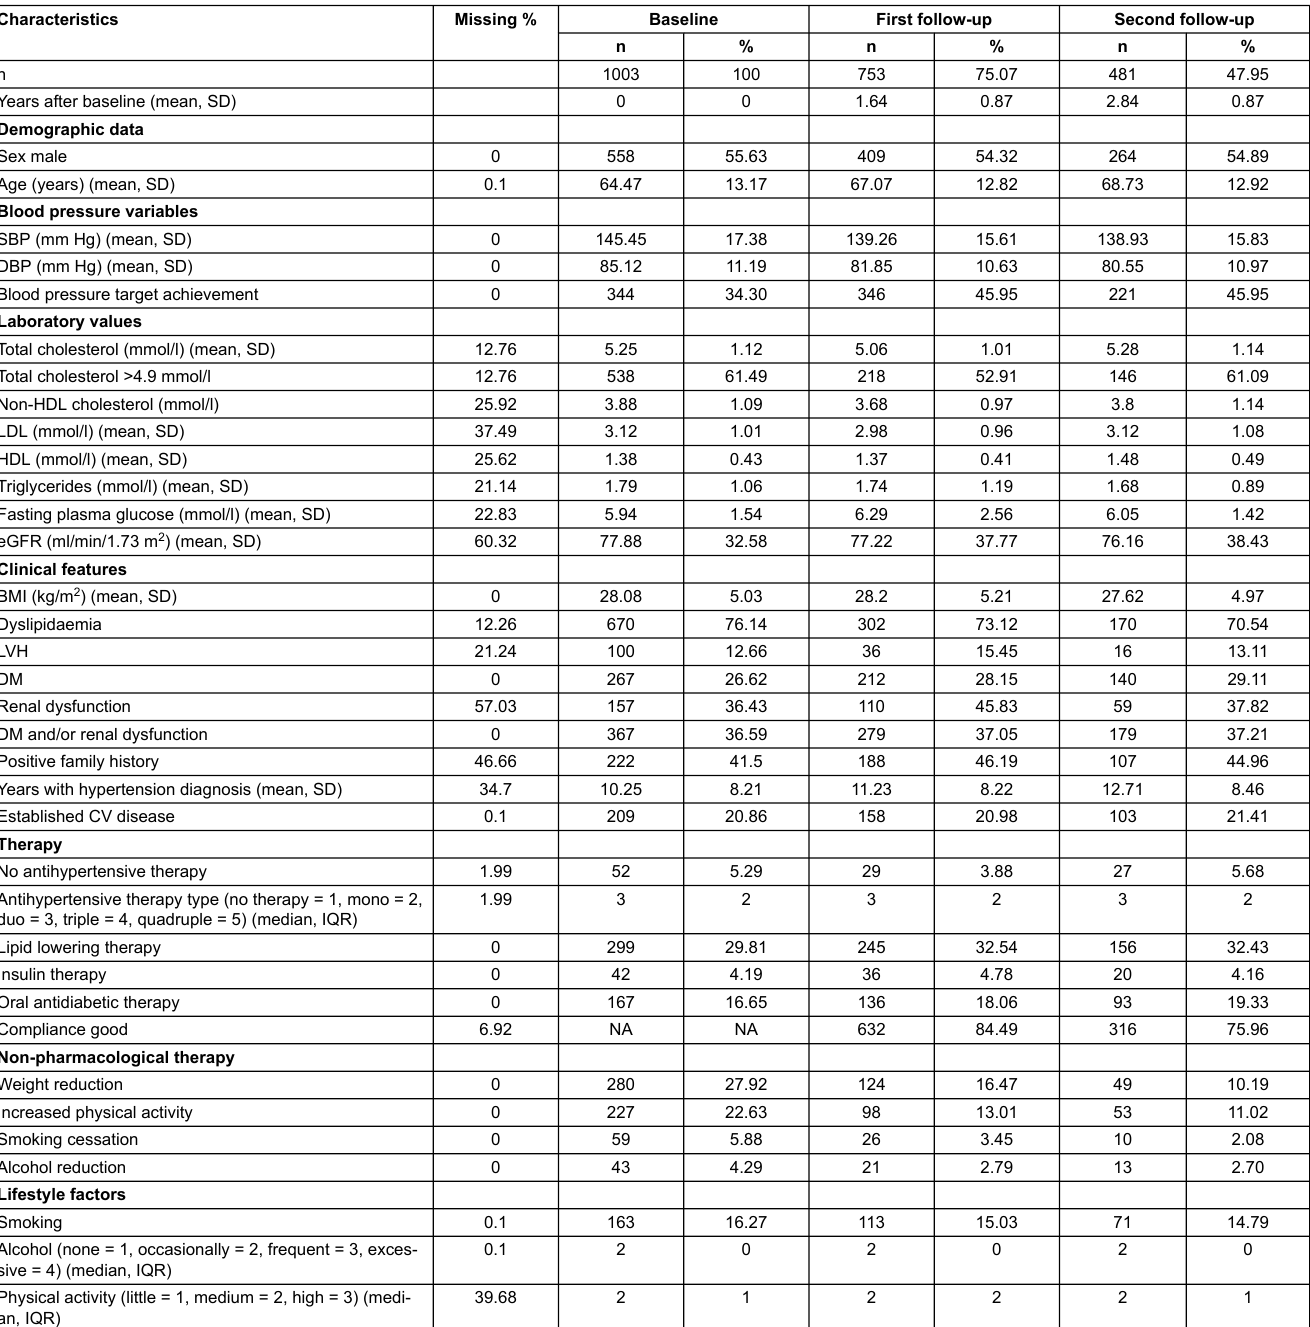
Table 1: Characteristics of study participants at baseline and follow-up examinations.